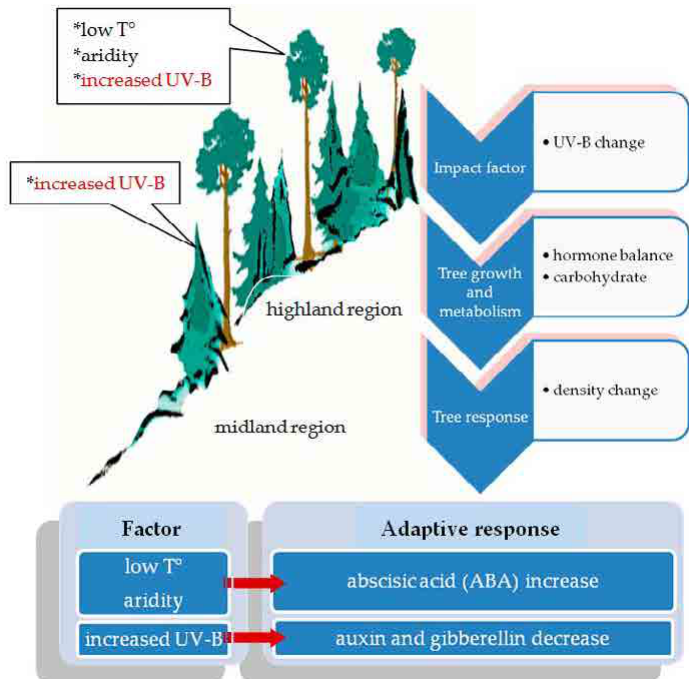
Fig. 13: The diagram shows the impact of UV-B, temperature and precipitation on tree response at different altitudes